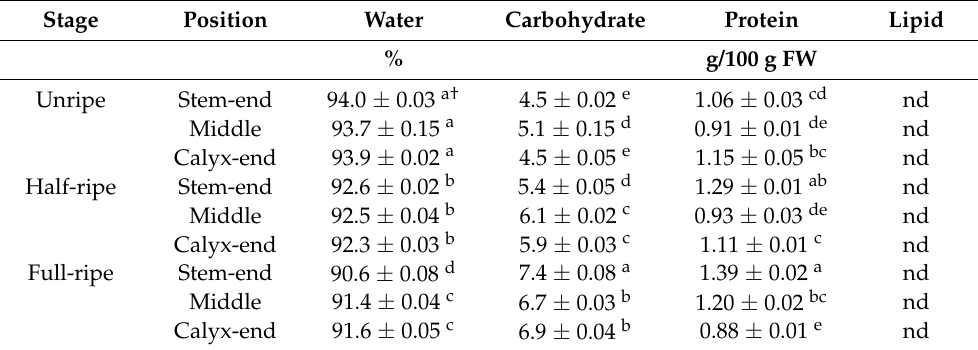
Table 4. Water, carbohydrate, protein, and lipid contents of “Tainung No. 2” Red papaya ( Carica papaya ) at 3 parts across ripening stages: unripe at 16 weeks after anthesis (WAA), half-ripe at 18 WAA, and full-ripe at 20